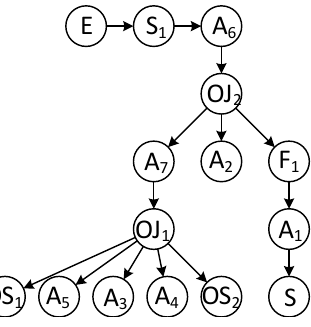
Figure 10. The post-dominator tree of the process of Figure